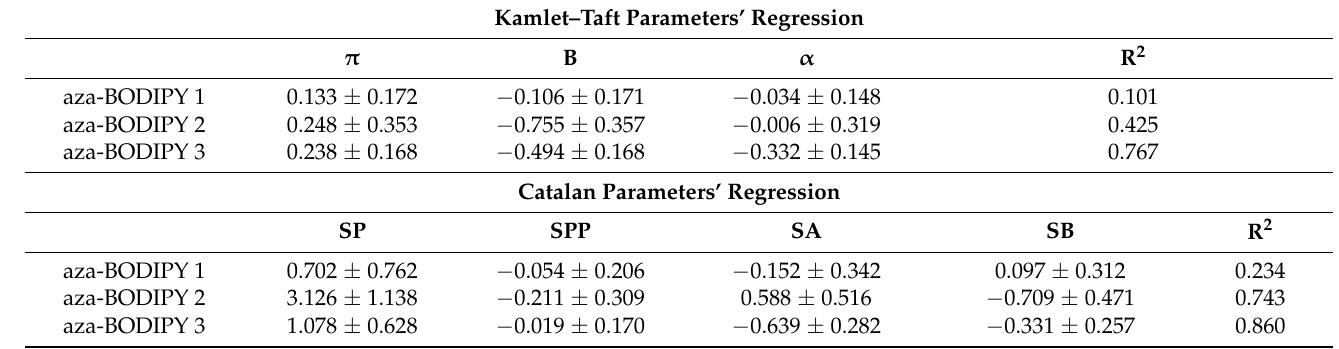
Table 5. The value of the reliability of the approximation (R 2 ) for the linear regression method of the values of the lifetime of the excited state in various